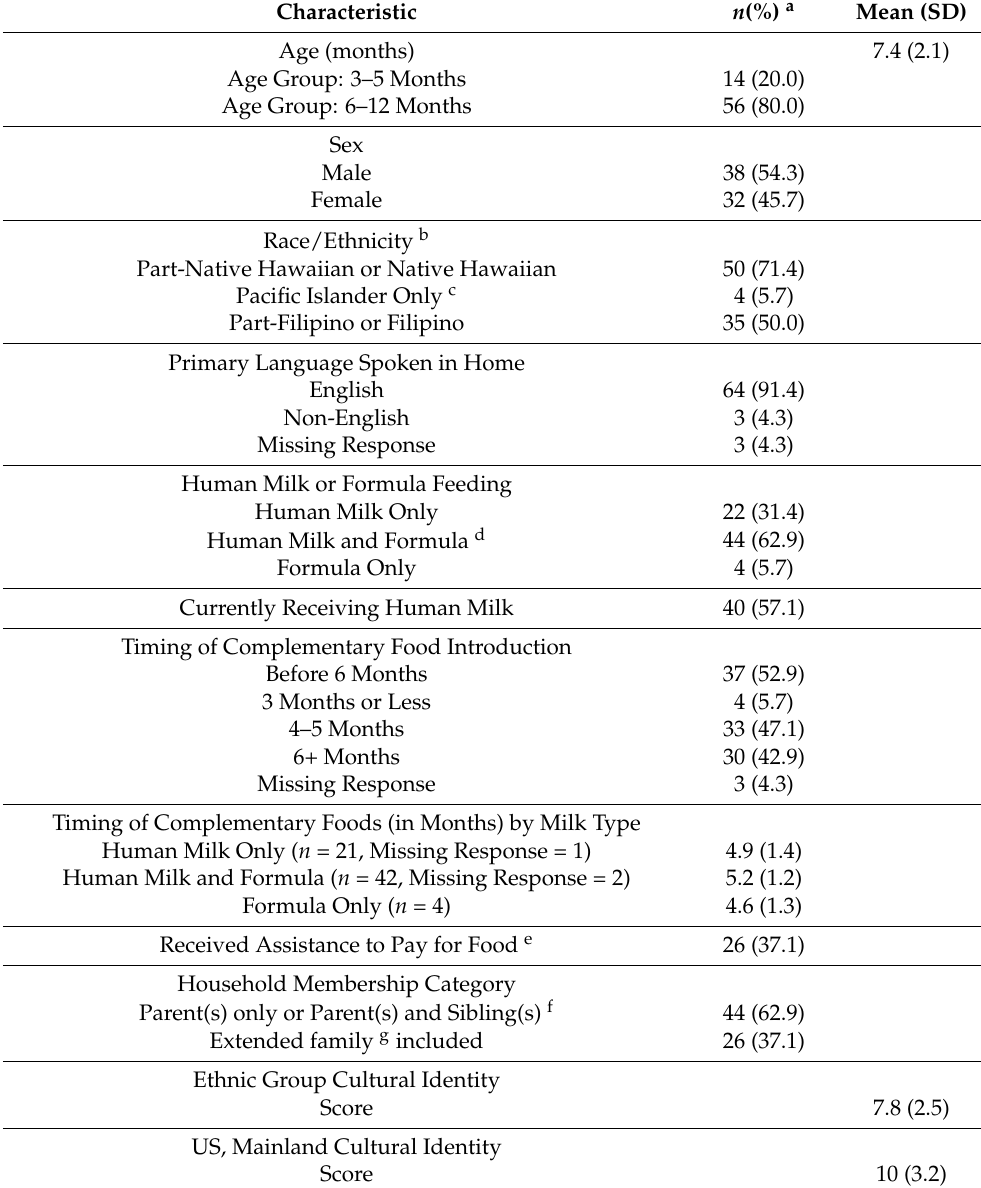
Table 1. Demographics and feeding practices of infants 3–12 months of age ( n =